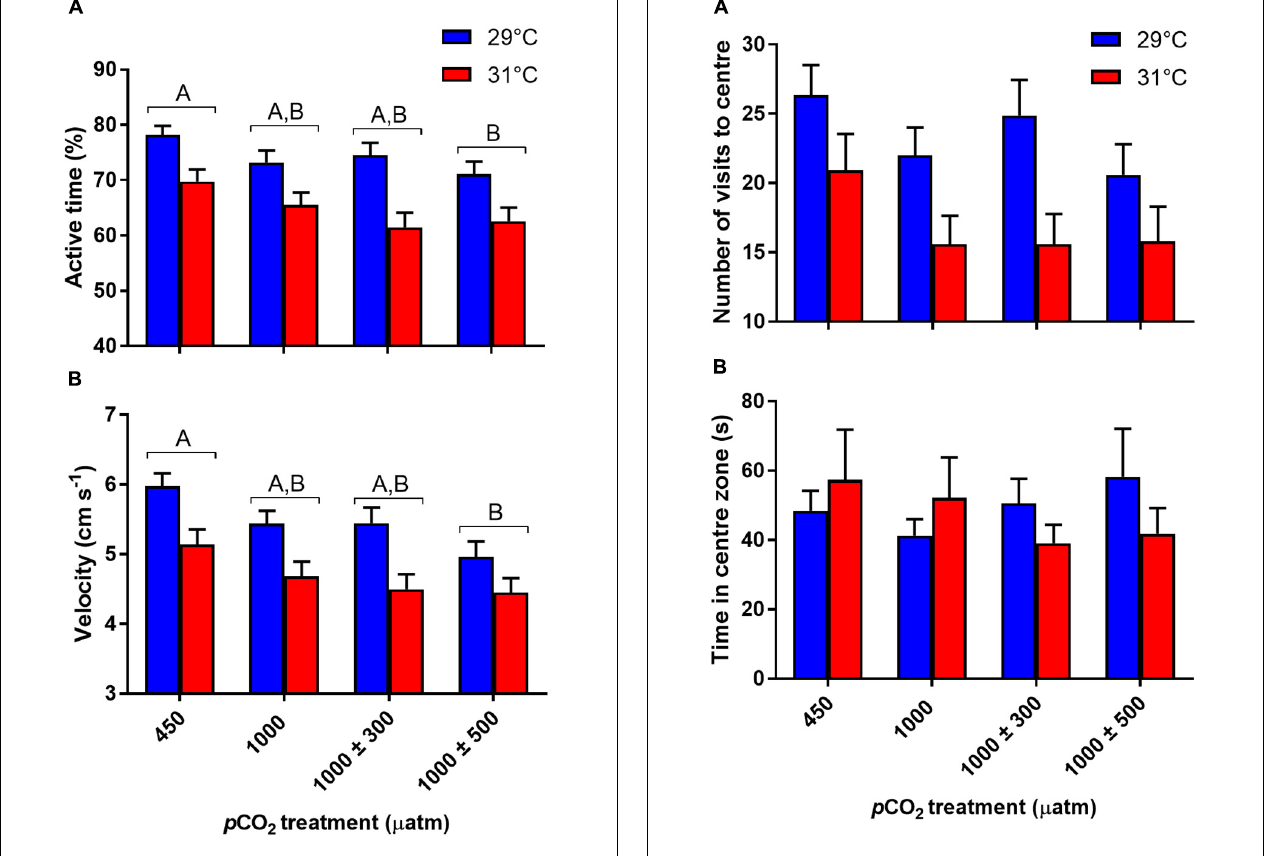
FIGURE 3 | Effects of elevated CO 2 and temperature on routine activity traits of juvenile A. polyacanthus. (A) % time active. (B) Average velocity. Different letters represent significant differences between p CO 2 treatments (Tukey’s, P < 0.05). Bars represent means ± SE.